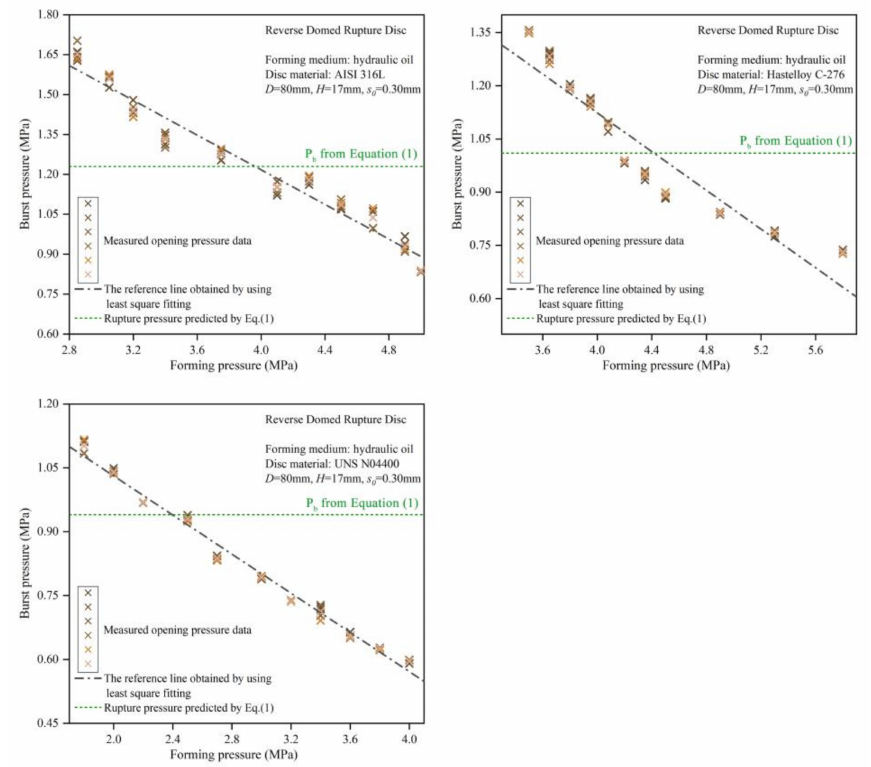
Figure 14. For the hydraulic forming method, the relationship between the burst pressure and the forming pressure of rupture discs with different materials with a diameter of 80